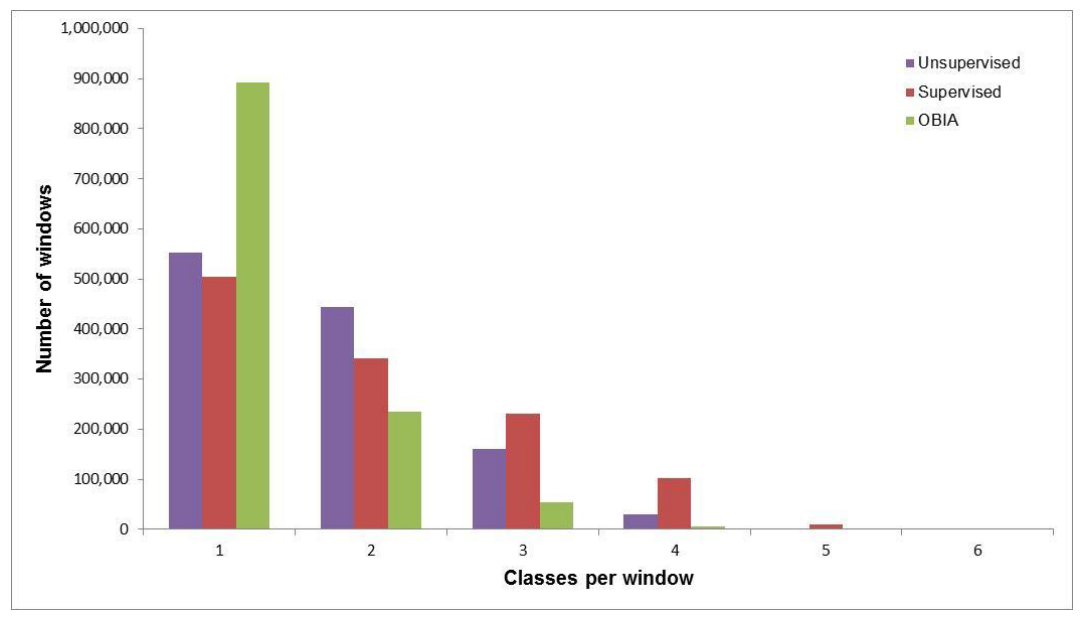
Figure 11. Diversity summary—number of land-use classes per moving window.